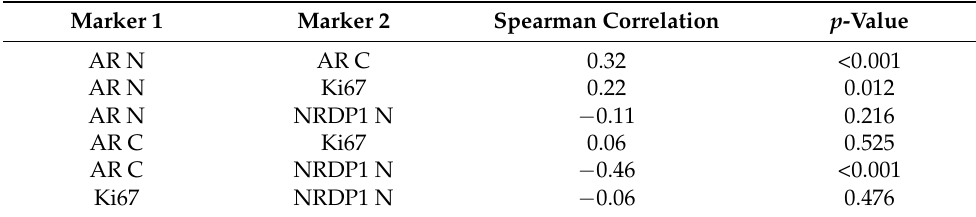
Table 4. Correlations between AR, NRDP1, and Ki67 expression in prostate cancer tumor cells from patients with stage 1/2 disease. N, nuclear localization; C, cytoplasmic localization. Bolded font denotes statistically significant correlations.